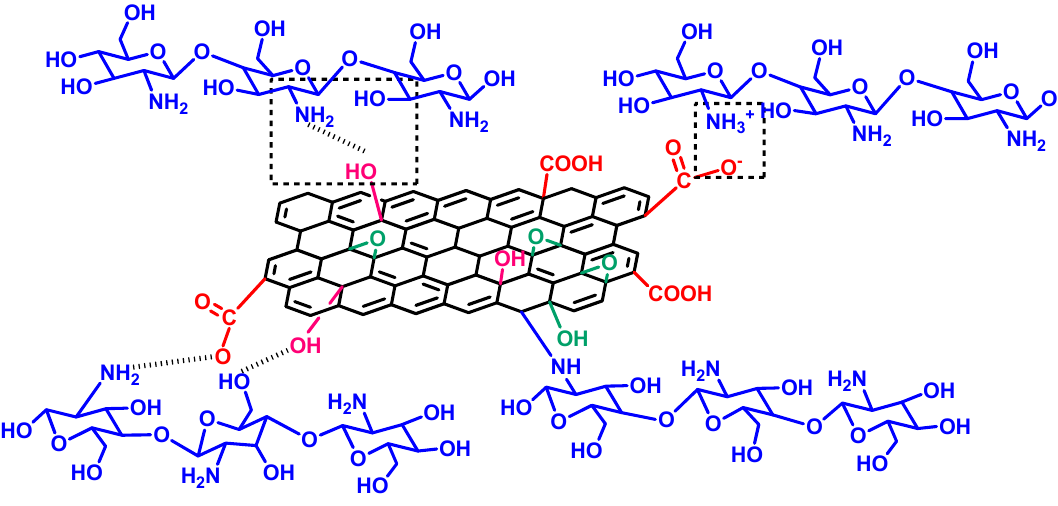
Figure 6. Covalently crosslinked graphene-CS membrane.